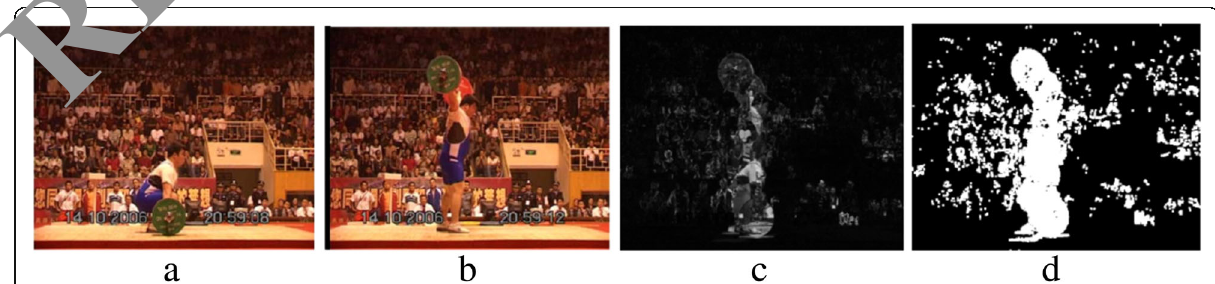
Fig. 2 The first frame of the picture is treated as a background